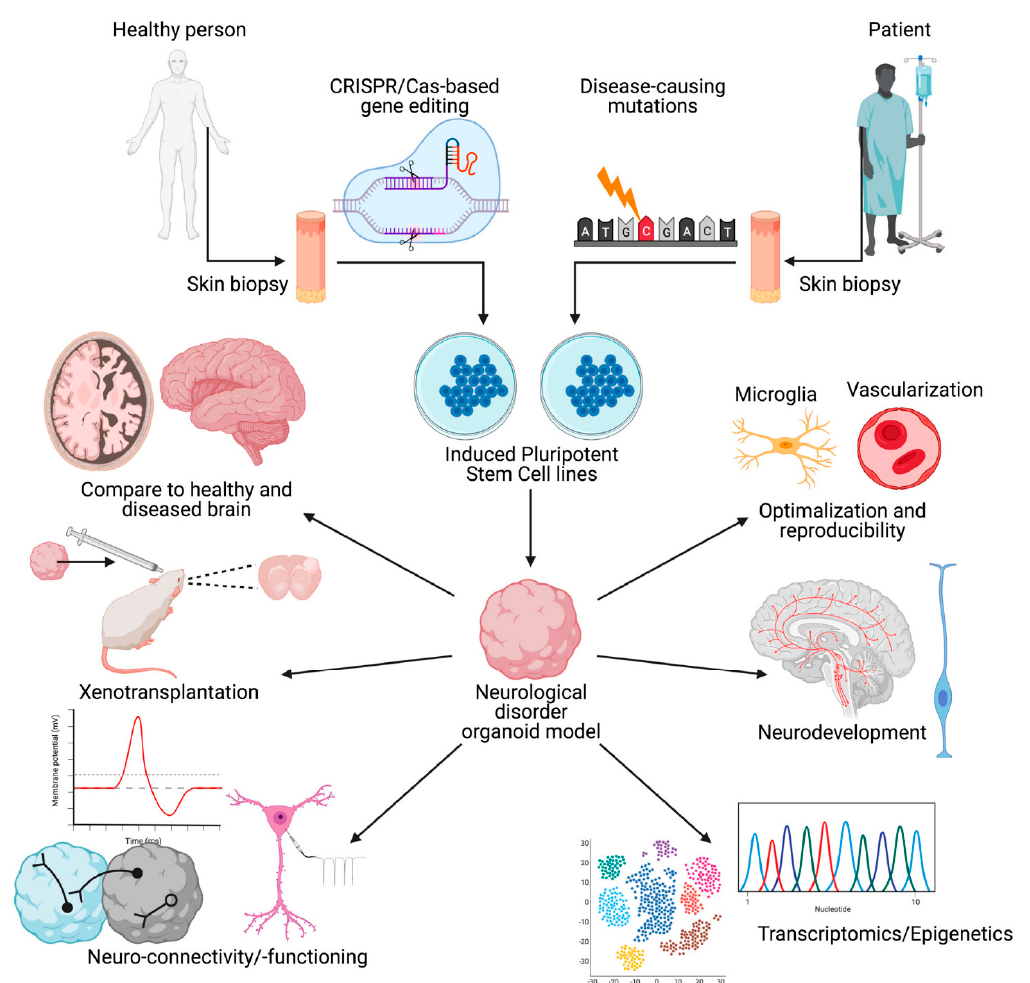
Figure 3. Schematic overview of the creation of and uses for organoid models of neurological disor- ders. Neurodegenerative, neurodevelopmental, and neuropsychiatric disorders can be modeled with the aid of brain organoids. Both neurofunctional and neurodevelopmental aspects can be in- vestigated with a possibility for comparison between healthy and diseased brain organoids depend- ing on the source or manipulations introduced, such as genetic manipulation and environmental stressors. In addition to the use of these models for studying pathogenesis, xenotransplantation of brain organoids into experimental animal brains has been proposed for treatment purposes or fur- ther studies in vivo. In these models, neural connectivity between different regions can also be stud- ied, for example, in the assembloids of two brain regions. This figure has been reproduced from [60] under an open access Creative Common CC BY license granted by